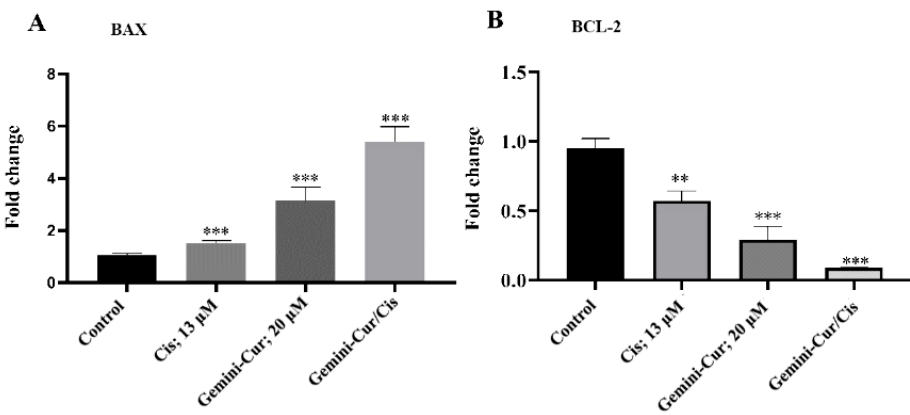
Figure 6. Quantitative analysis of the expression of apoptotic genes by real-time PCR. Relative expression for BAX ( A ) and BCL-2 ( B ) in MDA-MB-231 cells. Values represent mean ± standard deviation of three independent experiments; ** p < 0.01 and *** p < 0.001.